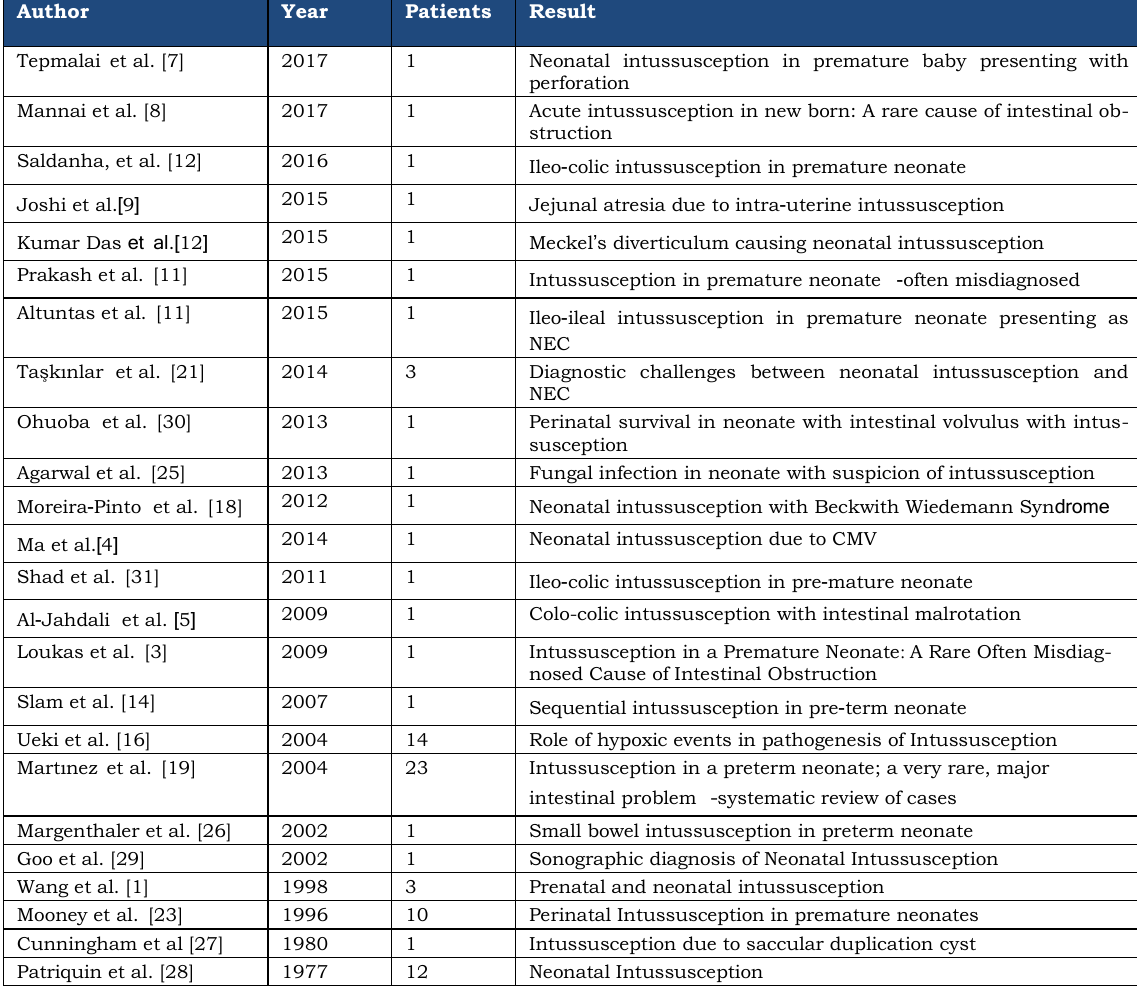
Table 1 - Studies describing the patients of neonatal intussusception